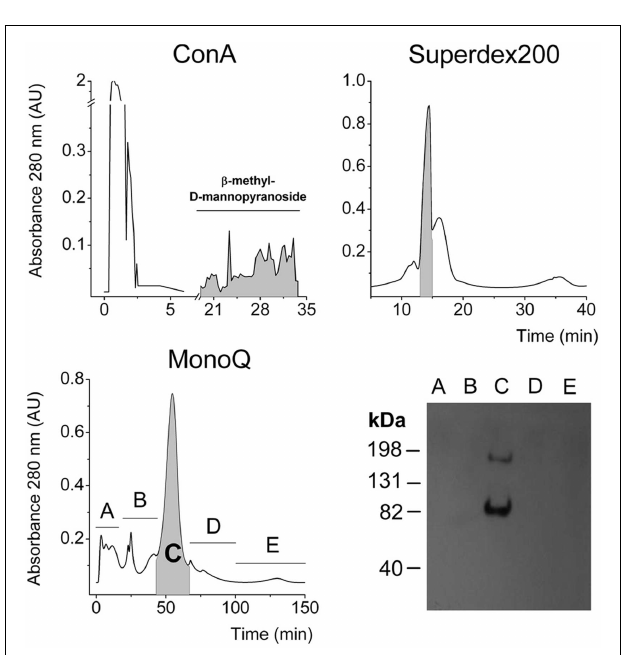
FIGURE 5 |Three-step purification of SIR from the supernatant of cultured hepatocytes . Chromatograms from Con-A affinity, gel filtration Superdex 200, and anionic exchange chromatographies. In each purification step, the faded fractions were pooled and assessed for α -IR byWestern blot to follow purification. Finally, a representativeWestern blot of each collected fraction from the last purification step.